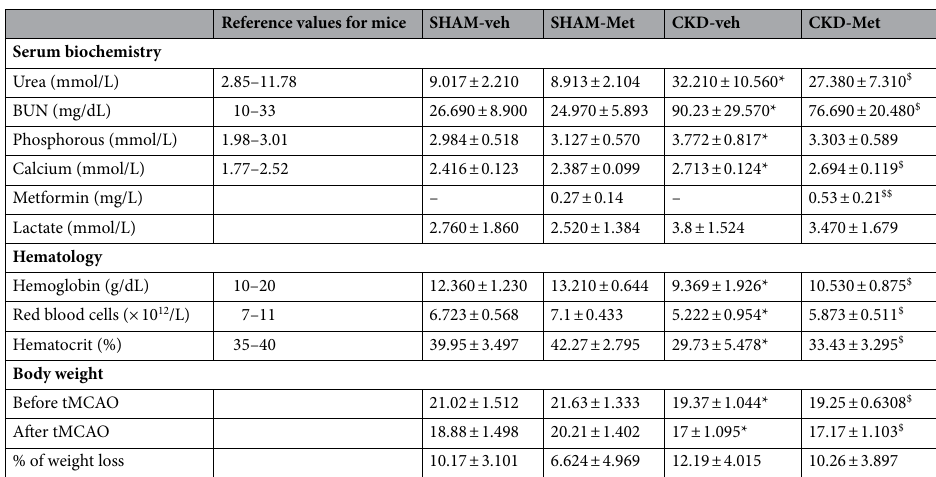
Table 1. Routine serum biochemistry and hematology parameters. BUN blood urea nitrogen, CKD chronic kidney disease, CKD-veh CKD-vehicle, CKD-met CKD metformin, SHAM-veh SHAM-vehicle, SHAM-met SHAM Metformin. Data are expressed as the mean ± SD. *p < 0.05, CKD-veh vs. SHAM-veh mice. $ p < 0.05, $$ p < 0.01, CKD-met vs. SHAM-met